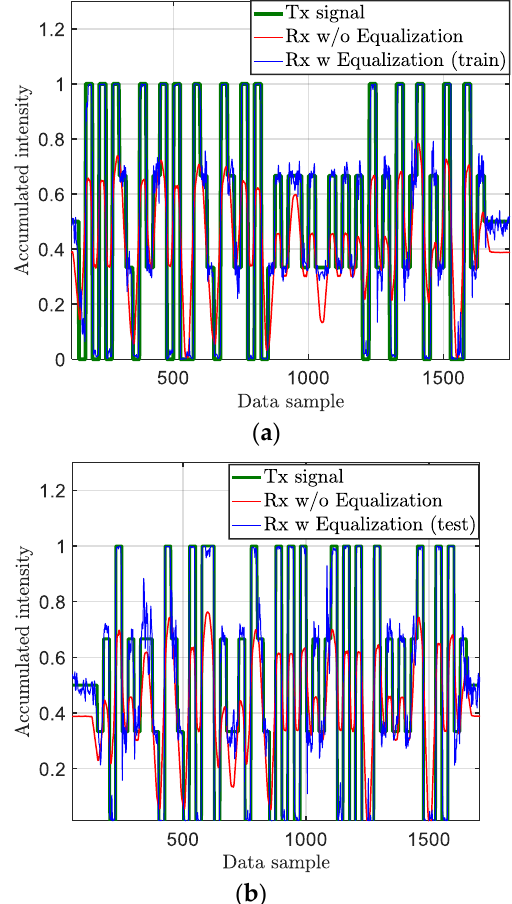
Figure 9. An example of the transmitted and received signal with and without equalization for CP 4-PAM and 𝑁 pps of 18.5 row pixels/symbol: ( a ) training sets, and ( b ) testing sets.